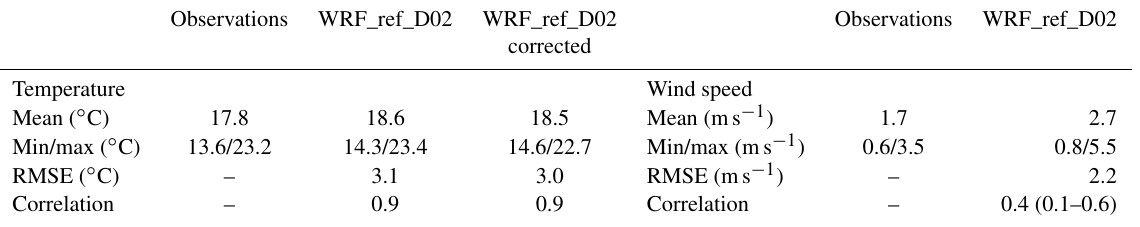
Table 5. Statistical overview of the model performance averaged over the time period of January–June 2013 and all available stations based on 3-hourly data. Station measurements are included in the statistics if the data availability is over 70% (Table